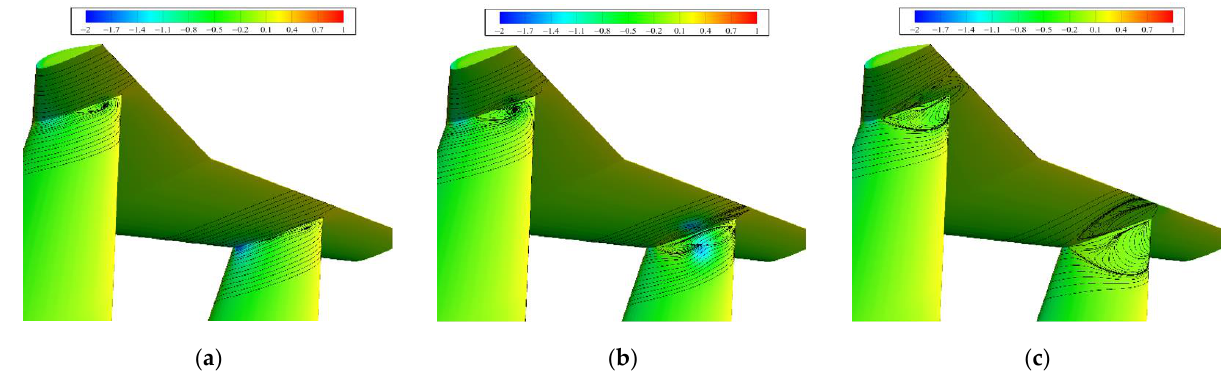
Figure 12. Streamlines and C p distribution on the suction side of the vertical tail parts: β = ( a ) 0°, ( b ) 2°, and ( c ) 4°.